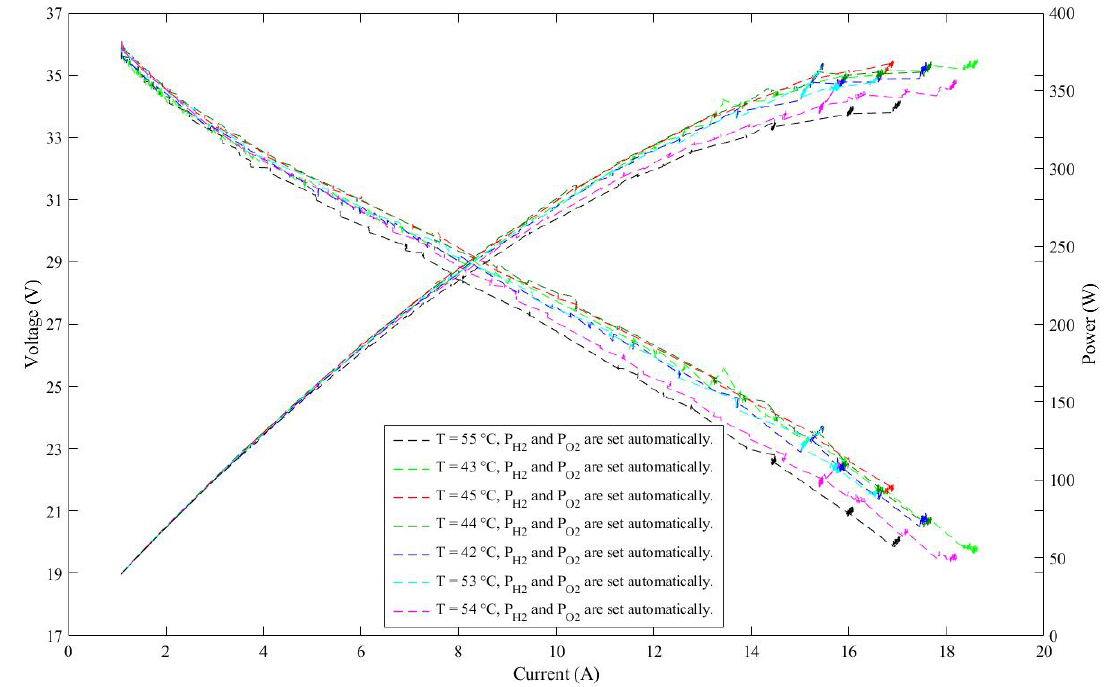
Figure 14. Experimental power and potential Vs current characteristic curves of the FC-42 Evaluation